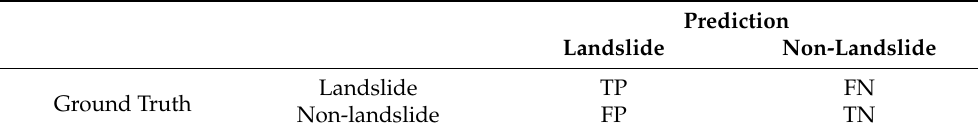
Table 2. Confusion matrix for landslides extraction